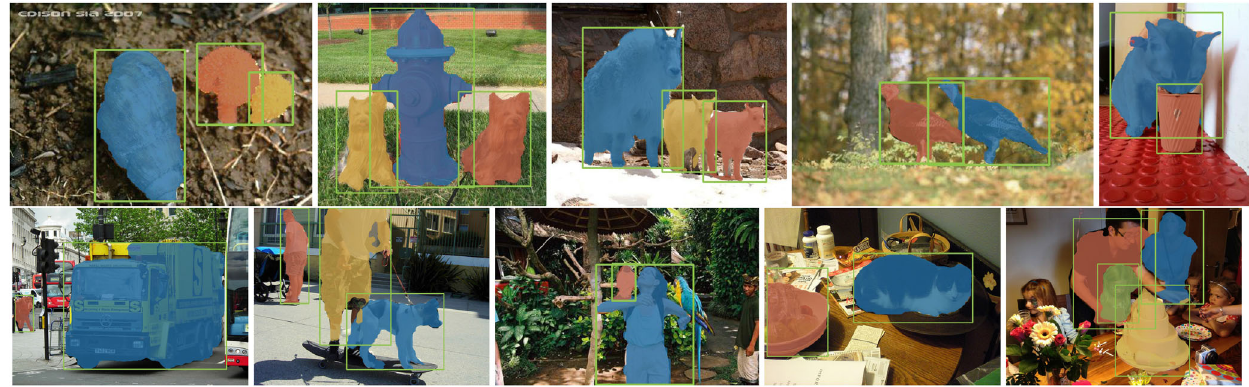
Fig. 7 Above: selected examples of instance-level saliency segmentation results on the dataset proposed by Ref. [9]. Below: examples with more complicated targets and backgrounds. Even partially occluded instances can be well distinguished and segmented by S4Net.